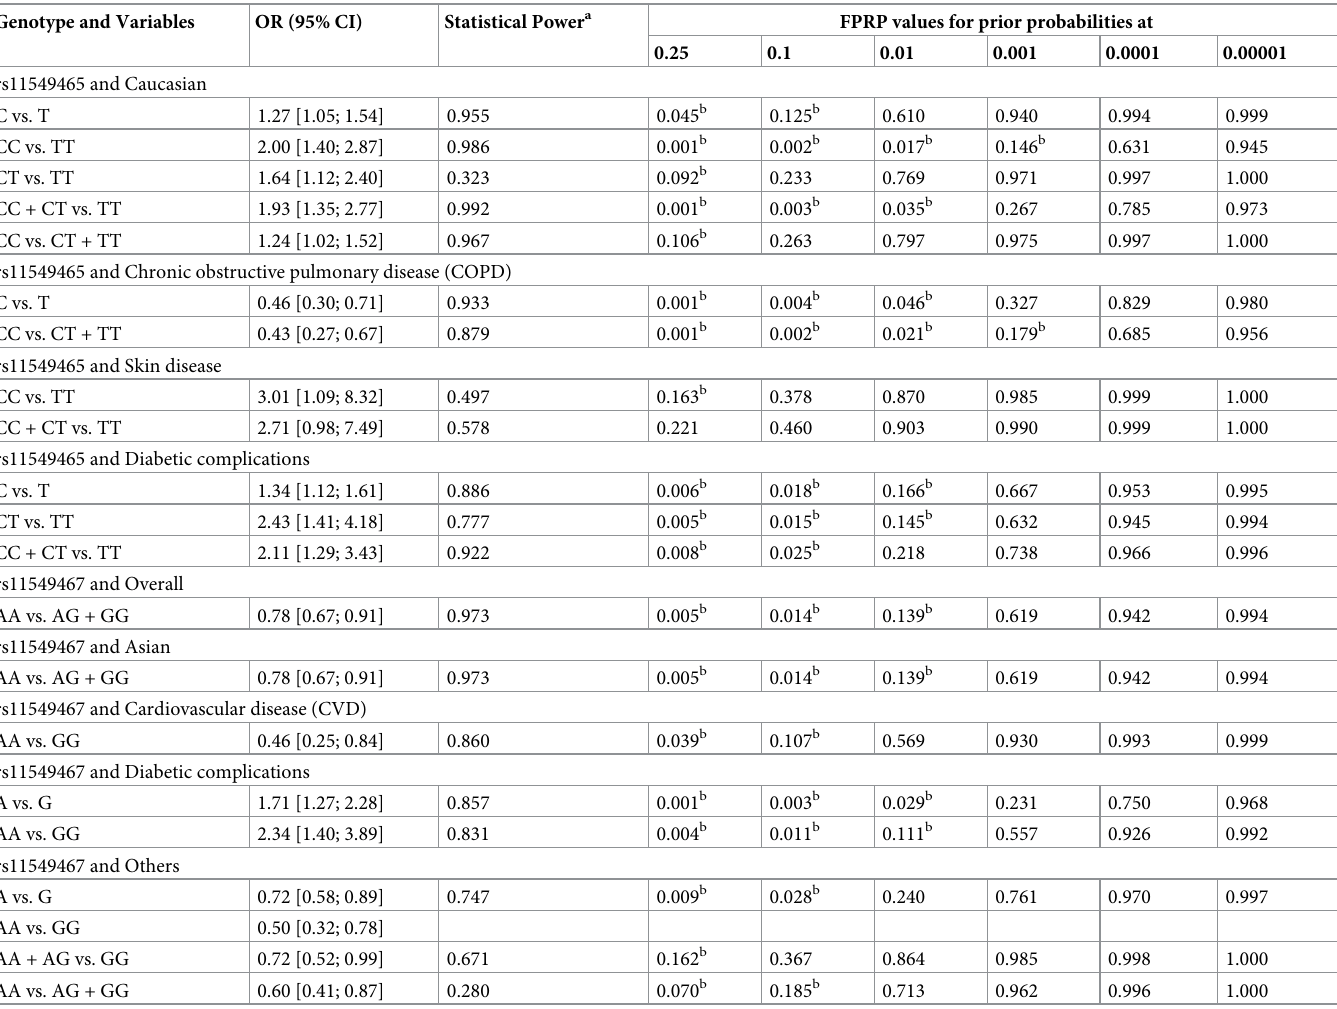
Table 4. Results of false positive report probability analysis for significant